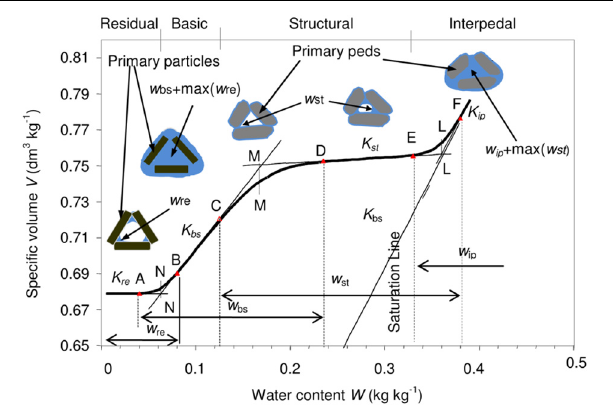
FIGURE 1 | Various configurations of air and water partitioning into the two pore systems, inter and intra primary peds, related to the shrinkage phases of a standard Shrinkage Curve [water content vs. specific volume]. The various water pools [ w re , w bs , w st , and w ip ] are represented with their domain of variations. The linear and curvilinear shrinkage phases are delimited by the transition points (A–F). Points N (cid:3) , M (cid:3) , and L (cid:3) are the intersection points of the tangents at those linear phases of the Shrinkage Curve. (Adapted from Braudeau et al.,